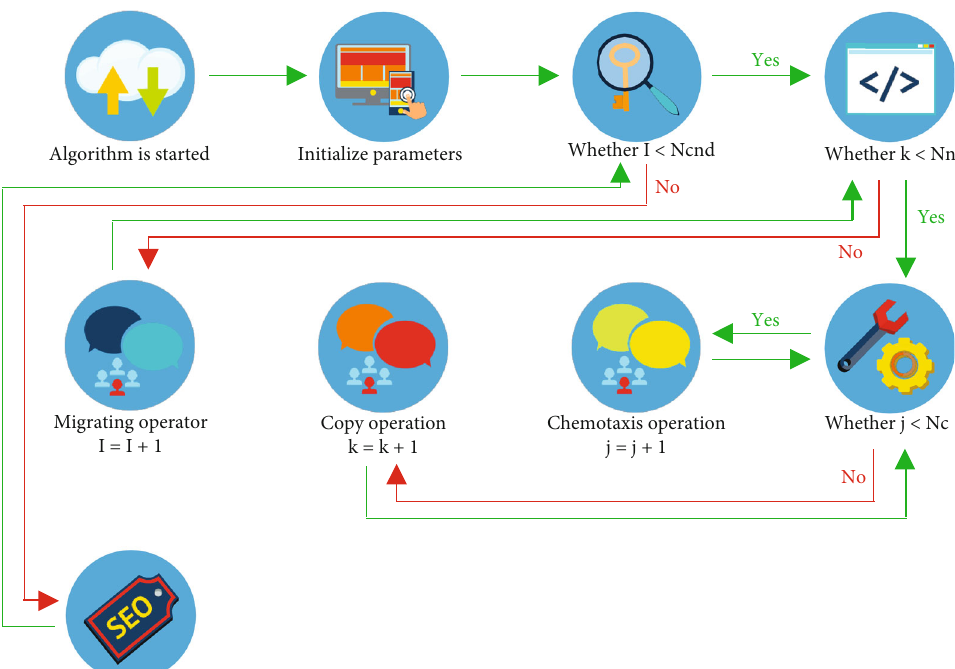
Figure 5: Flowchart of heuristic search